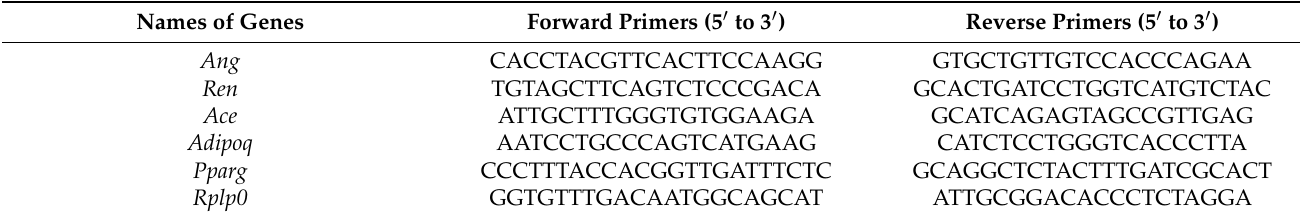
Table 6. Sequences of gene specific primers used for quantitative real-time PCR. Names of